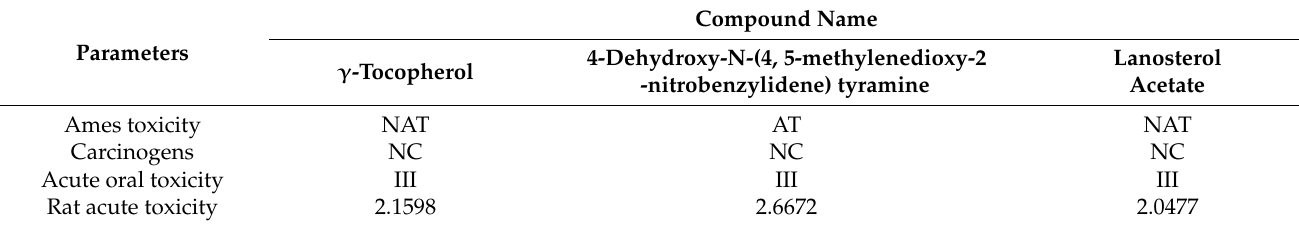
Table 9. Toxicological properties of the key bioactives on AKT1 (PDB ID: 4GV1) in the molecular docking study.